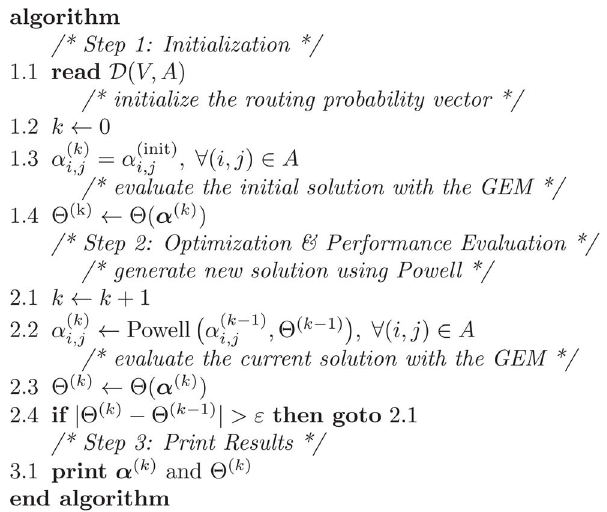
Figure 1. Structured overview of the methodology.